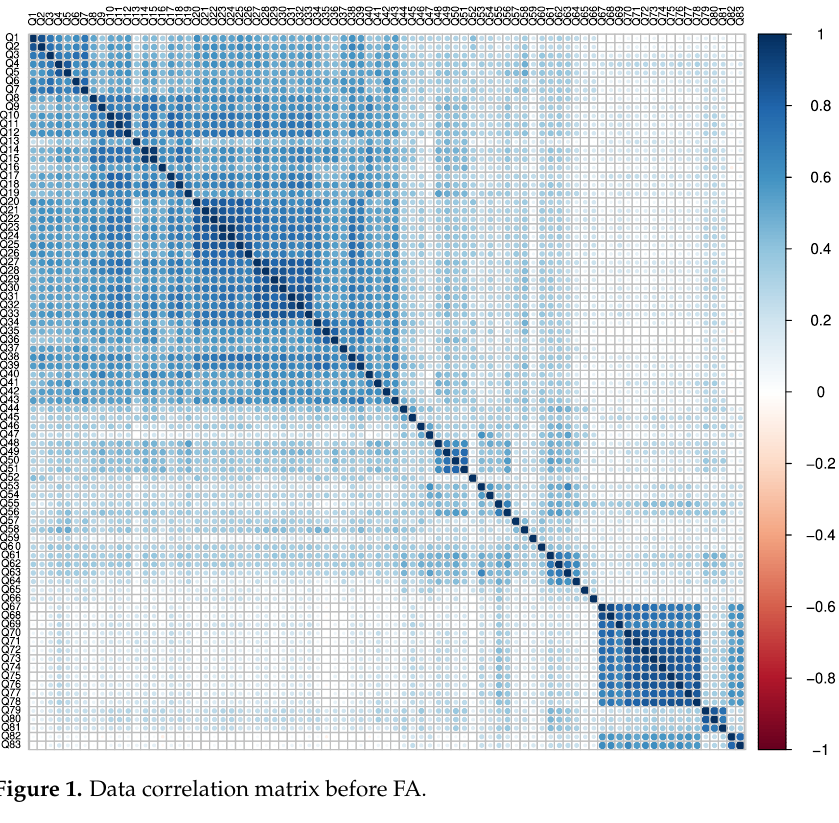
Figure 1. Data correlation matrix before FA.